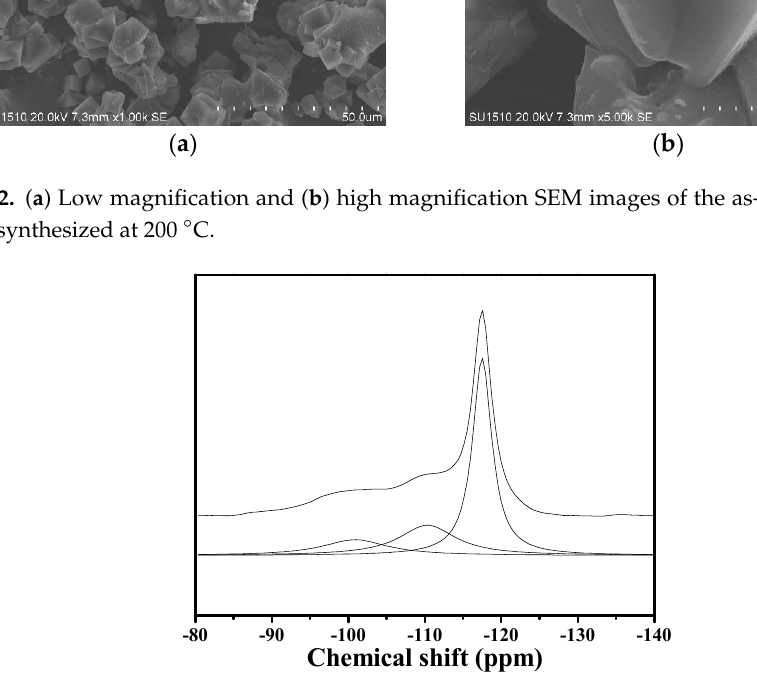
Figure 3. 29 Si MAS NMR spectrum of the as-made S–Si–SOD zeolite synthesized at 200 ◦